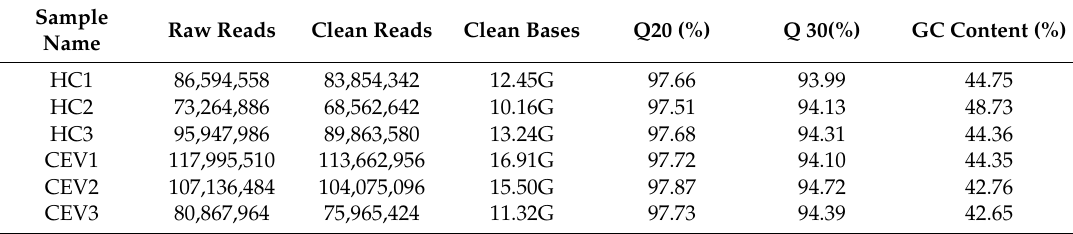
Table 1. The quality of sequencing data.